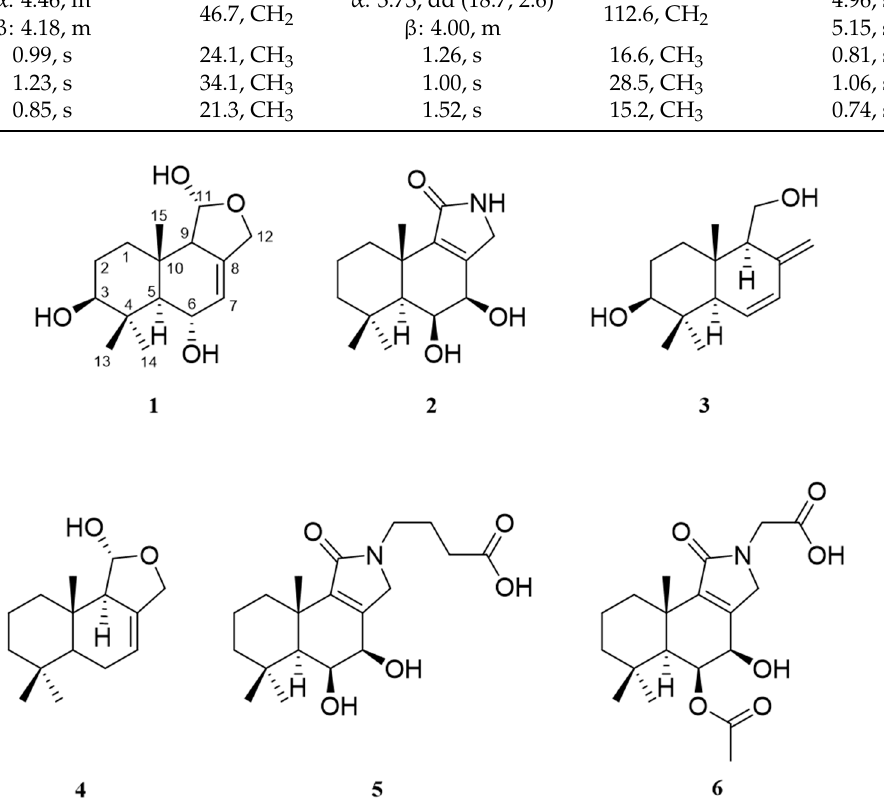
Figure 1. Chemical structures of compounds 1 – 3 from Perenniporia centrali-africana and compound 4 – 6 from Cerrena sp.